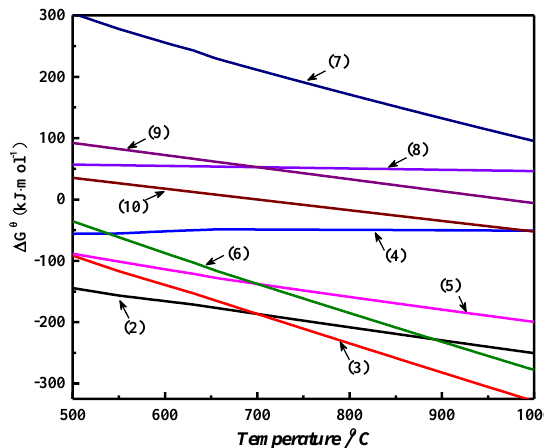
Figure 3. Relationship between ∆ G θ and temperature for each reaction in the system.